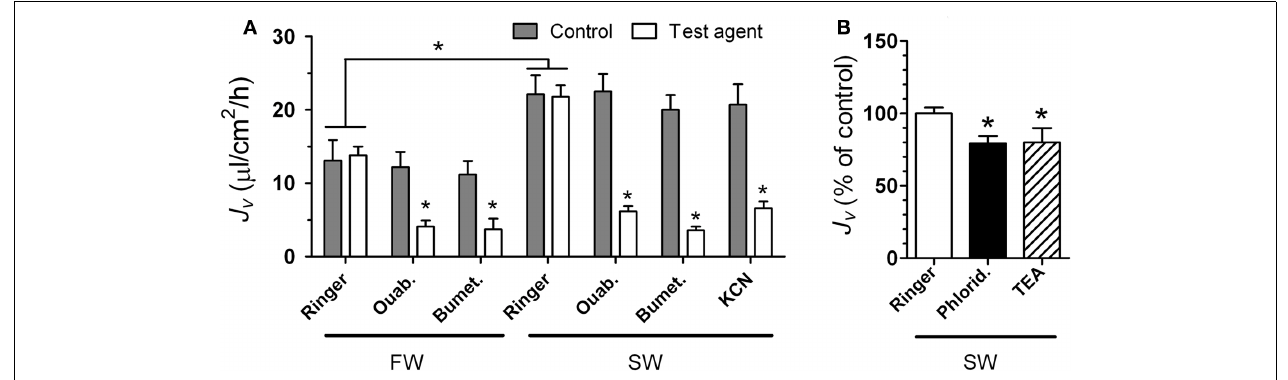
with the test agent before the effect was evaluated. All inhibitors were applied at 10 − 4 M concentrations. In (B) whole (i.e., middle + posterior) intestines from SW trout were used to measure J v (shown in % of control): phloridzin (1mmolL − 1 ) orTEA (10mmolL − 1 ) were added to the mucosal side. Asterisk indicates difference from control value (ringer; p < 0.05). All values represent mean ± SEM, n = 6–8.